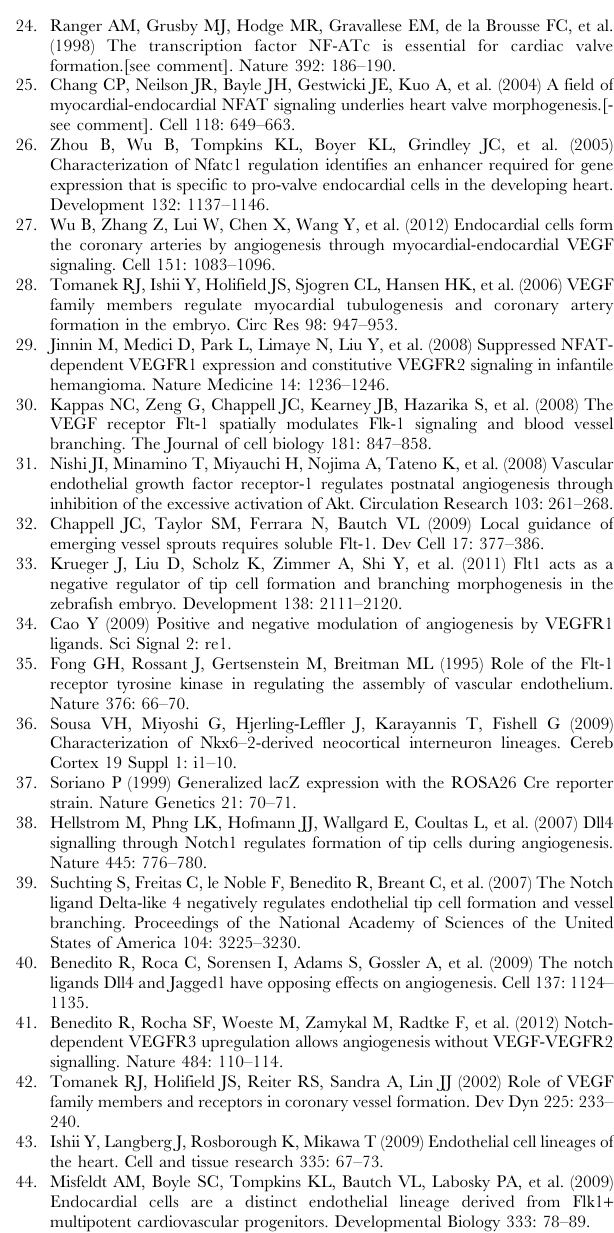
Table S1 List of endothelial gene expression examined by qRT-